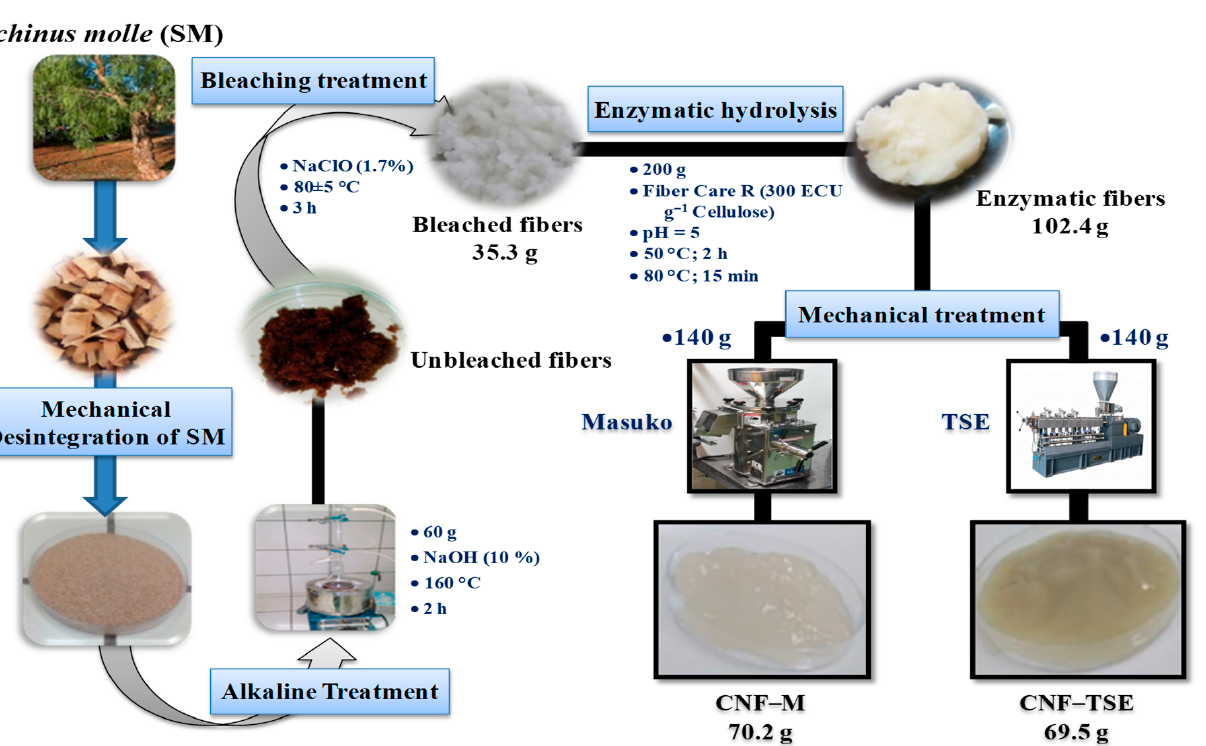
Figure 1. Schematic illustration of procedures used to produce CNF from Schinus molle .